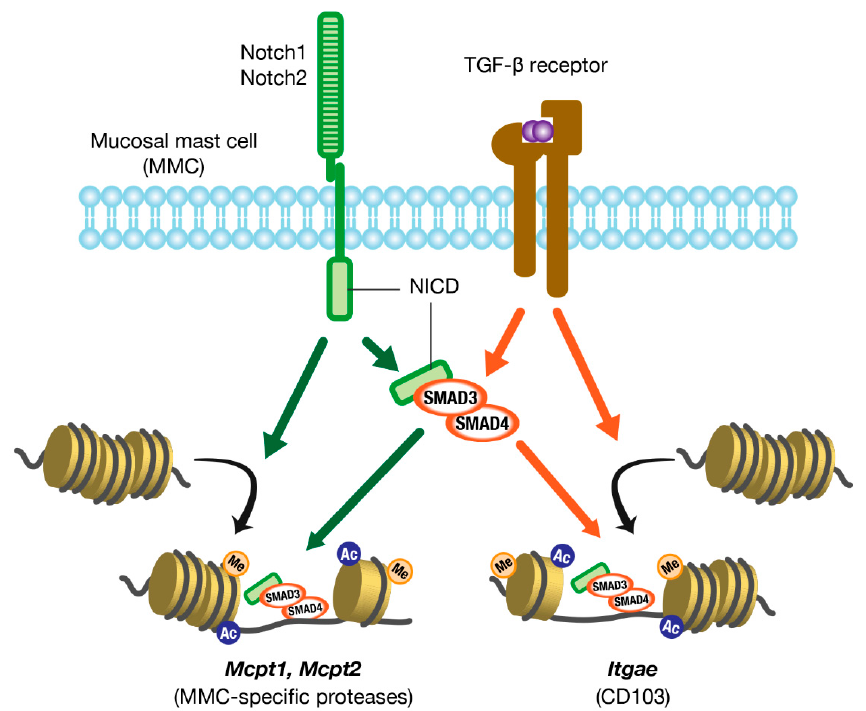
Figure 2. Molecular mechanisms of MMC marker gene expression. Notch and TGF- β signaling act synergistically and interdependently in the expression of MMC marker genes. MMC, mucosal mast cell; TGF- β , transforming growth factor- β ; NICD, Notch intracellular domain.